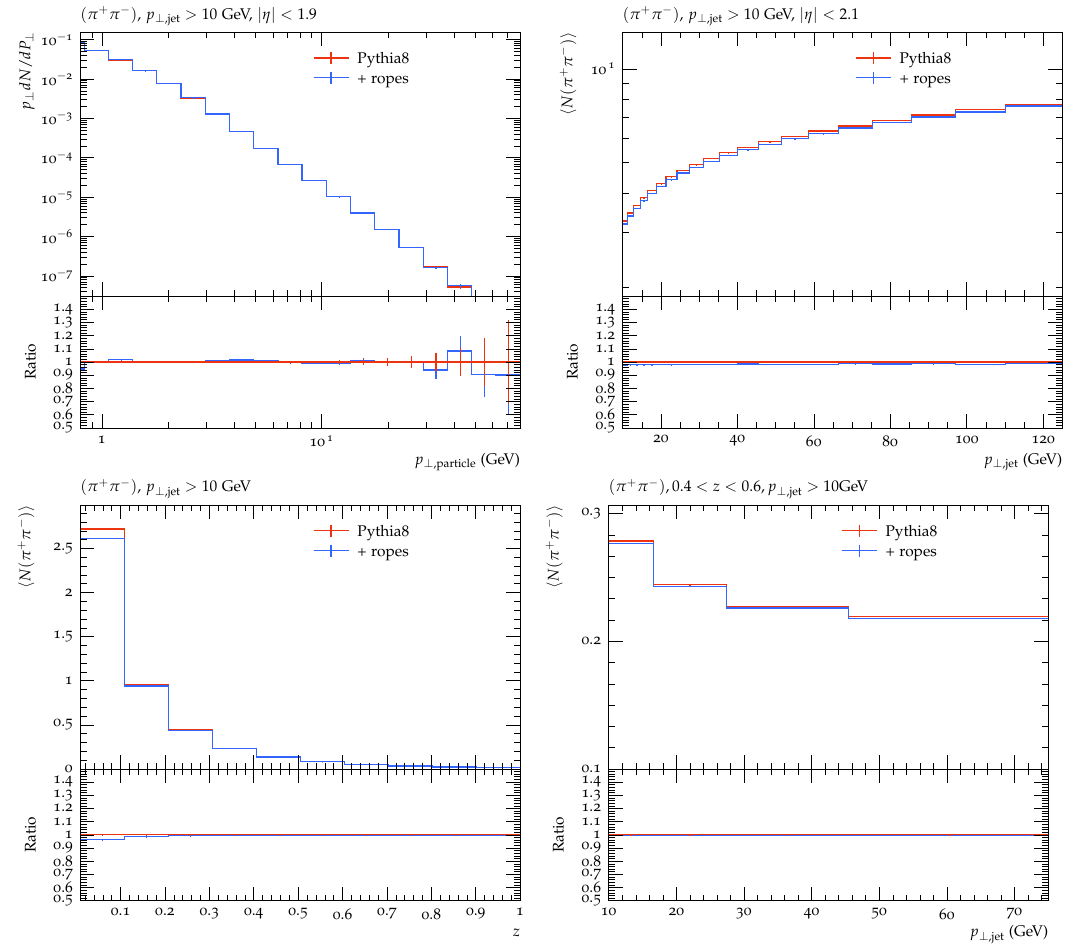
Figure 4: Pion yields in Z + jet events in 13 TeV pp collisions vs. p ⊥ (top left), vs. p ⊥ in the jet cone (top right), as a function of z = p ⊥ ,jet (bottom left), and vs. p ⊥ for 0.4 < z < 0.6 (bottom ,jet